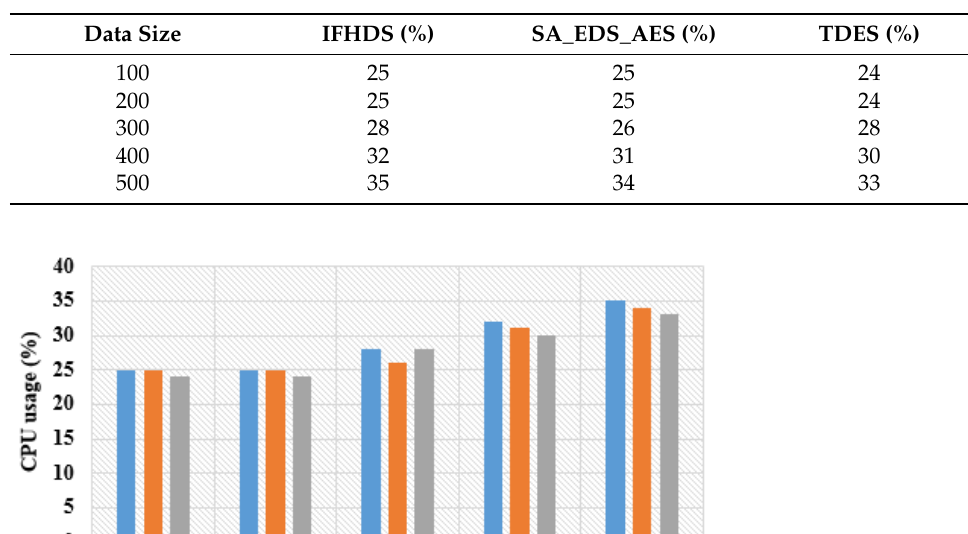
Table 6. TDES CPU usage comparison with existing techniques.